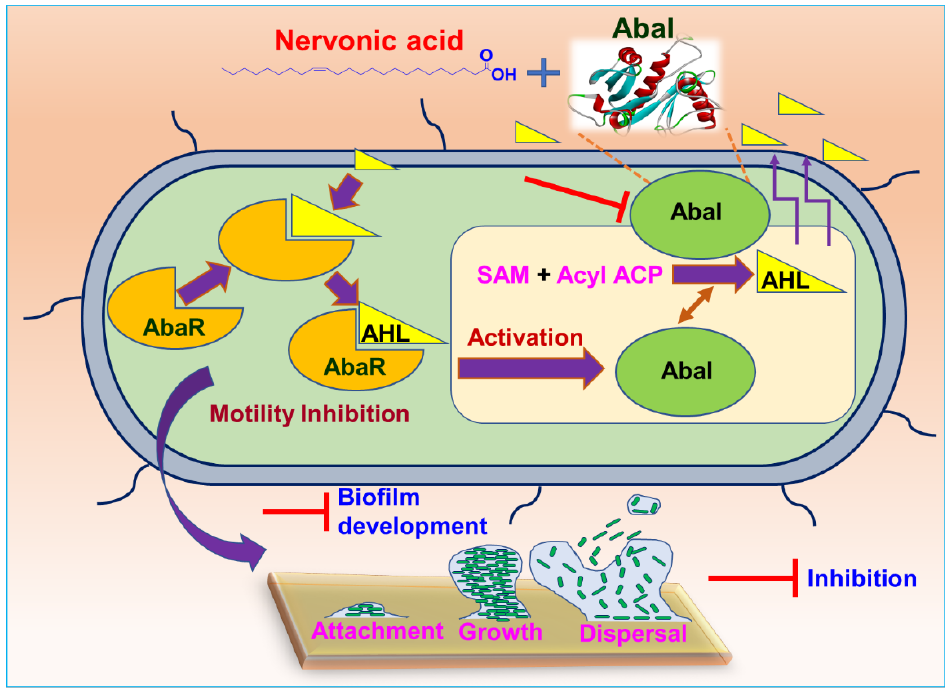
Figure 6. Plausible mechanism for the inhibition of A. baumannii quorum sensing by nervonic